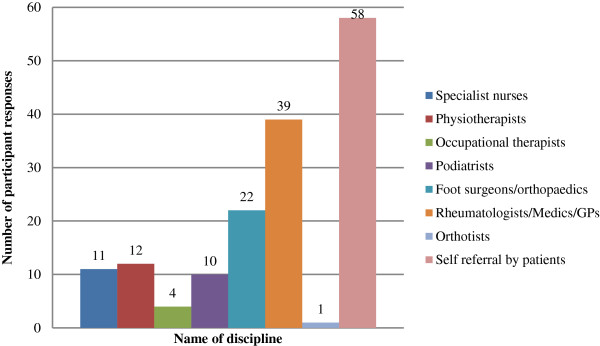
Bar chart indicating participants’ responses concerning the health professionals that refer patients with rheumatoid arthritis to podiatry.